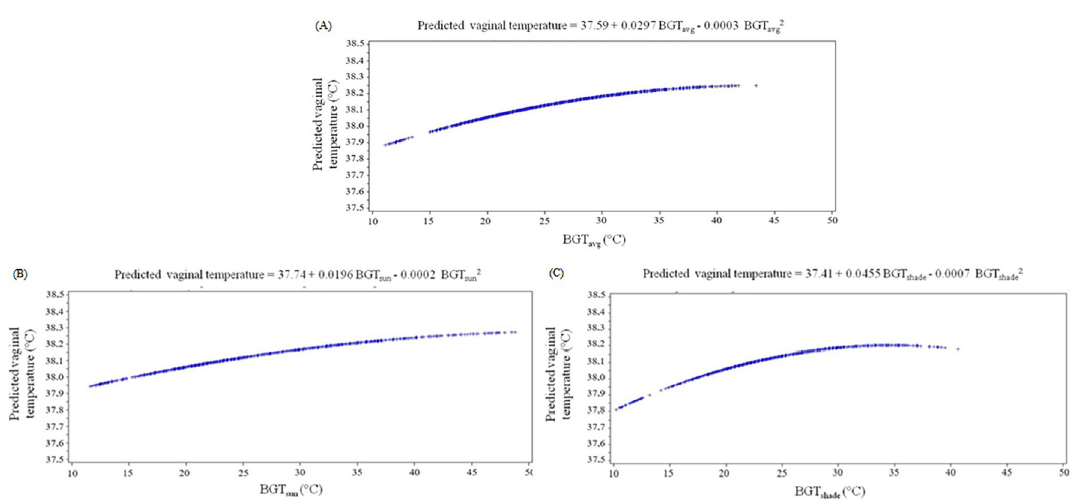
Fig 4. Vaginal temperature of Nellore heifers as a function of the average black globe temperature–BGT (A); BGT measured under the sun (B); and under the shade (C) of systems with different microclimatic conditions.